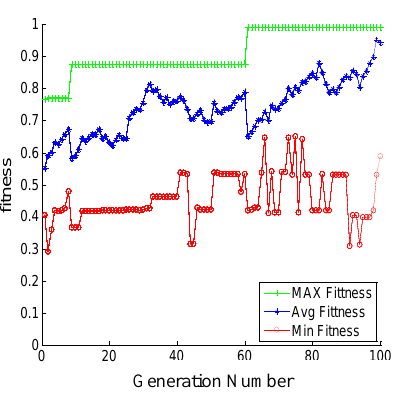
Figure 12. Convergence diagrams for F 4 . .